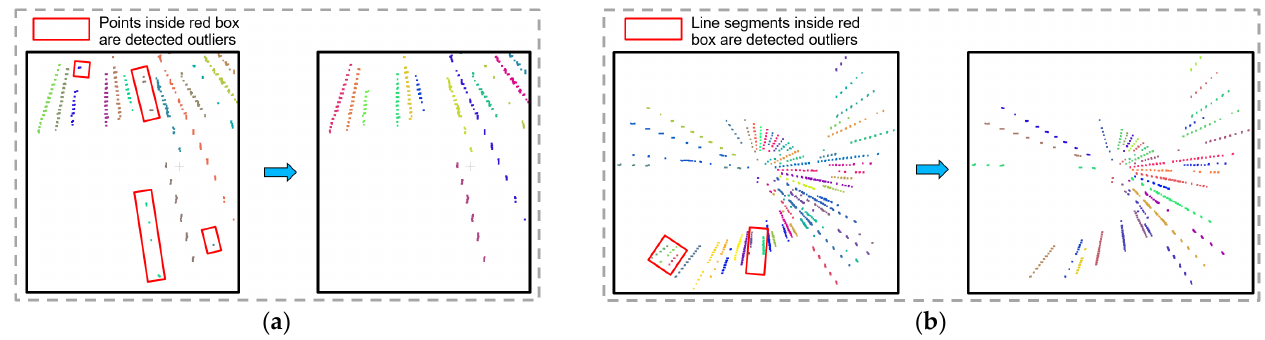
Figure 18. Examples of removed outliers: ( a ) point outliers (left: before, right: after) and ( b ) line- segment outliers. Line segments are colored by id (left: before, right: after).